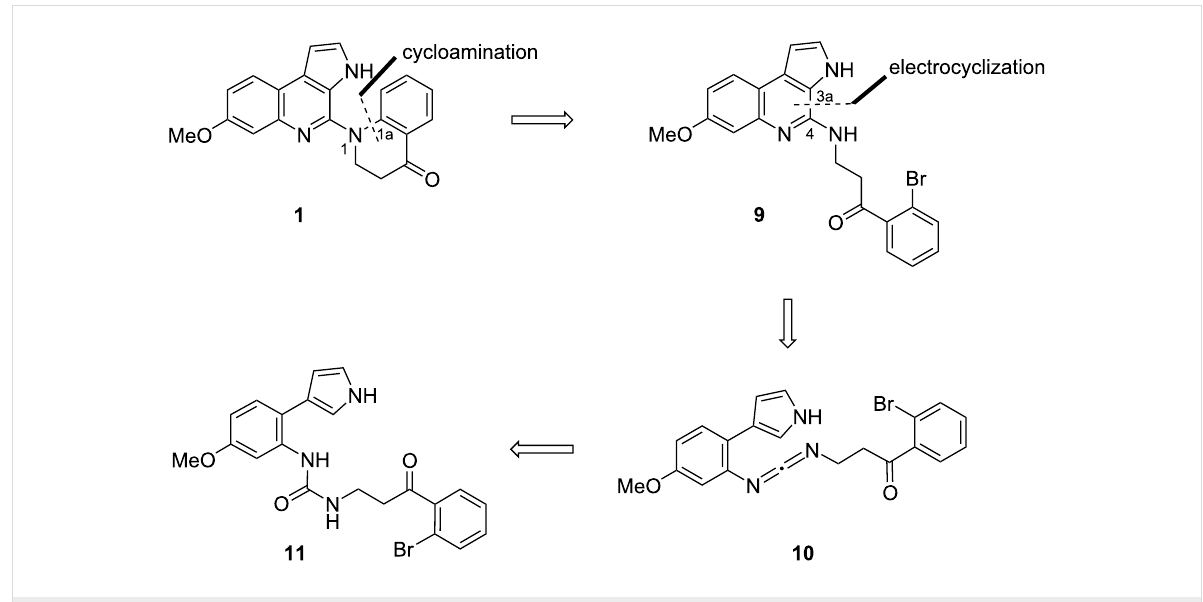
Scheme 2: Retrosynthetic analysis of the pyrrolo[2,3- c ]quinoline ring